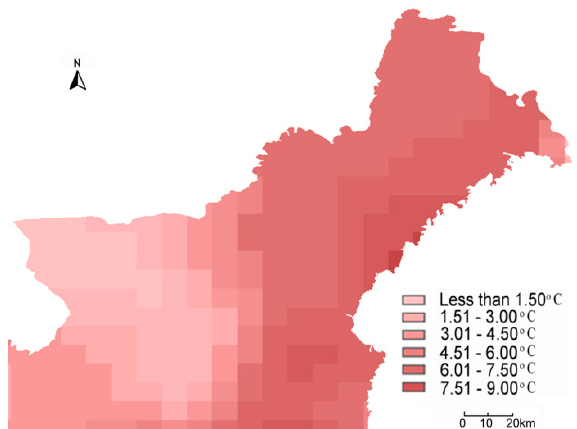
Figure 15. The map of average annual temperature evaluated for 50 years in the Tumen River Basin